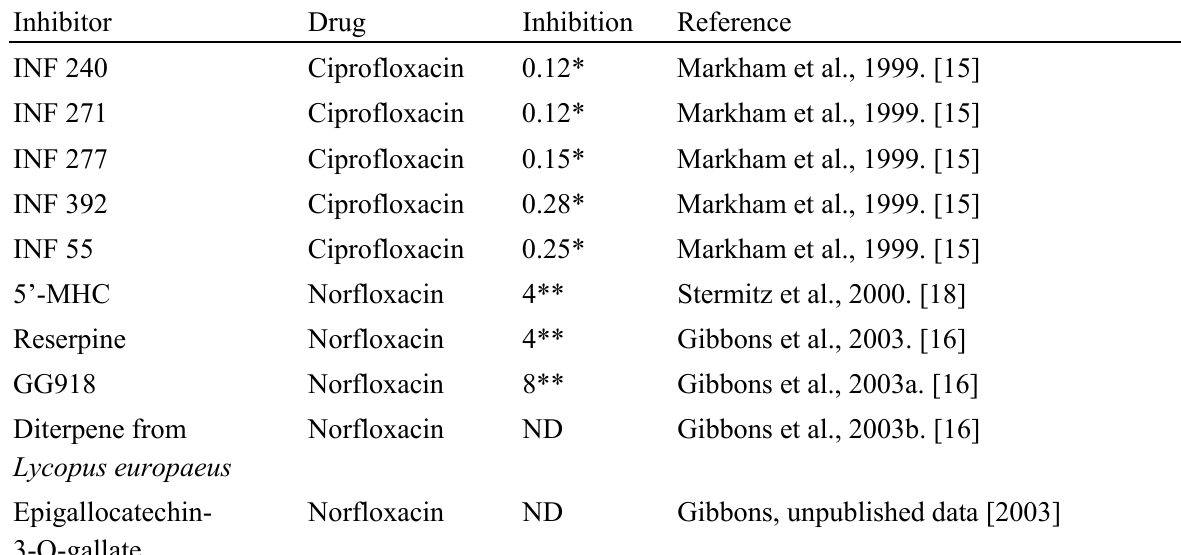
Table 1 . MDR modulation results for NorA inhibitors (5’-MHC depicted 5’-methoxyhydnocarpin).